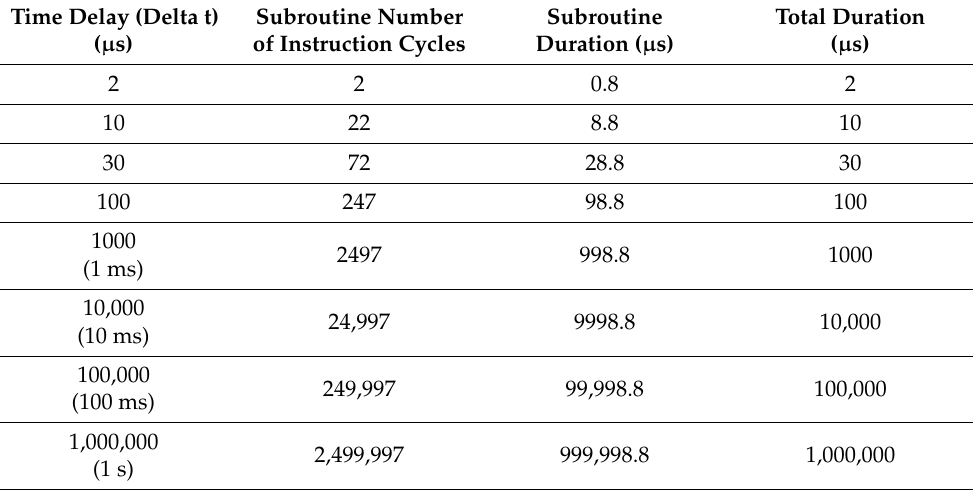
Table 3. Time delays and subroutine number of instruction cycles and duration